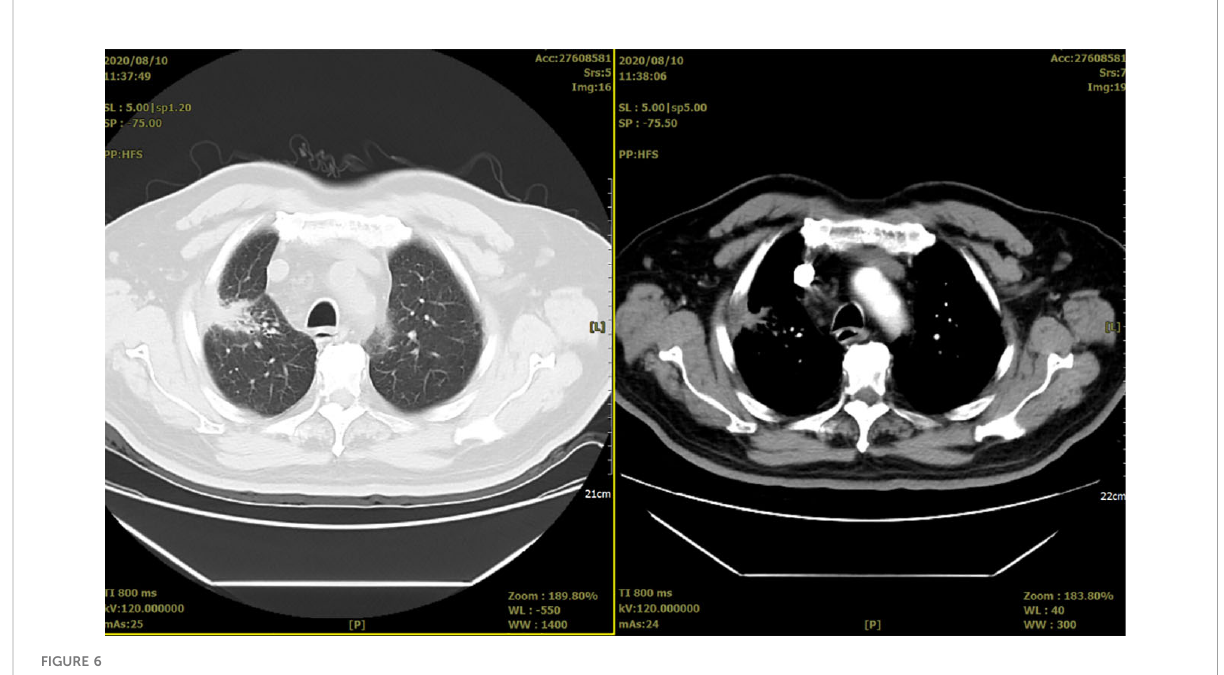
FIGURE 6 Two representative CTs of the patient on 10 August